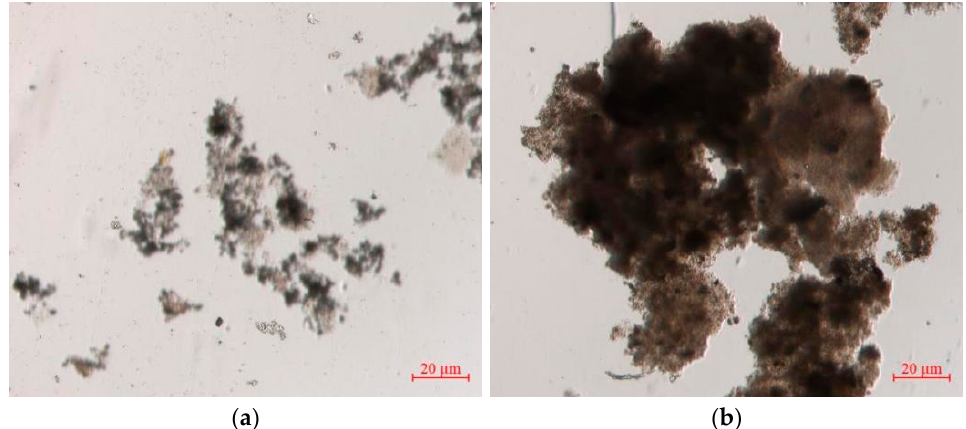
Figure 8. Microscopic observation of the thallus: ( a ) The S 0 -SADN operation stage; ( b ) The ANAMMOX start-up stage.